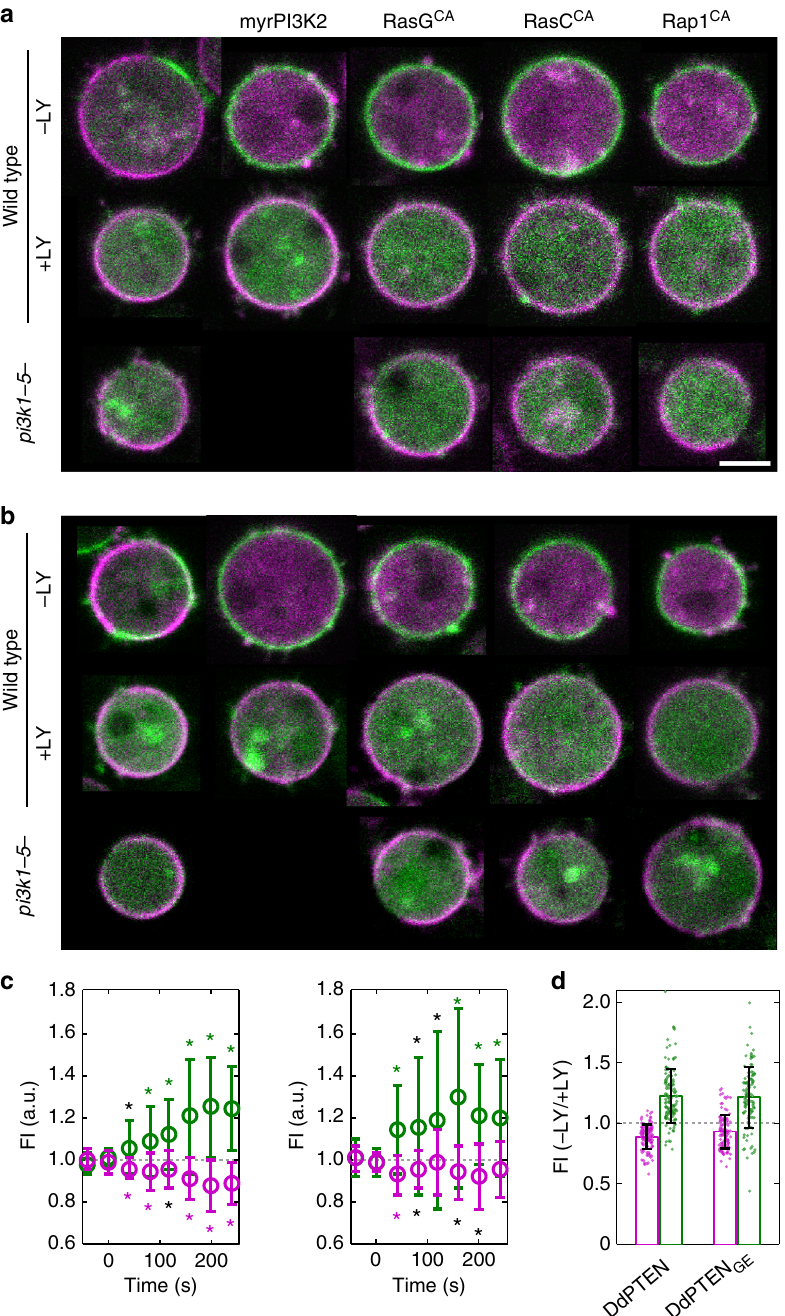
Fig. 3 Mutual inhibition between PIP3 and PTEN excludes each other from the membrane. a Confocal images of DdPTEN-Halo-TMR and PH PKB -eGFP in living cells expressing myrPI3K2 or constitutively active forms of small G proteins in the absence (top) or presence (middle) of 40 μ M LY294002 or in the background of pi3k1-5 -null (bottom). b Confocal images of DdPTEN G129E -Halo-TMR and PH PKB -eGFP in living cells expressing myrPI3K2 or constitutively active form of small G proteins. c Quanti fi cation of the fl uorescence intensities of DdPTEN-Halo (open magenta circle; left; n = 17) or DdPTEN G129E -Halo (right; n = 15) and PH PKB -eGFP (open green circle) on the cell membrane of wild-type cells expressing myrPI3K2 before and after the dilution of LY294002 at t = 0. Error bars, SD. Black and colored asterisks indicate signi fi cant differences after the dilution ( P < 0.05, P < 0.01). d Fluorescence intensities of DdPTEN (magenta) and PH PKB -eGFP (green) after the dilution relative to before the dilution. The data obtained by 7 measurements at different time points in the same cells as c were shown. Error bars, SD. P = 0.012 and 0.742 (DdPTEN versus DdPTEN G129E for DdPTEN and PH PKB ). P values were obtained by Welch ’ s t test. Scale bar, 5 μ